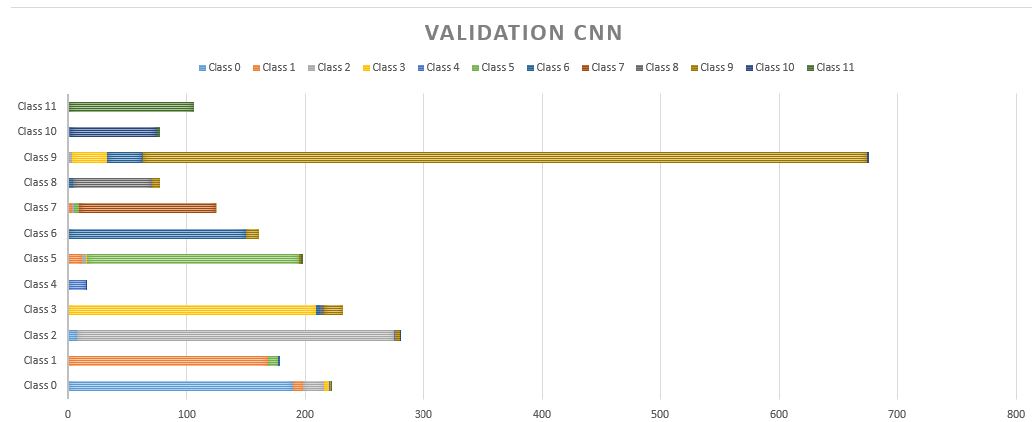
Figure 11. Cross-validation results with 20% for the NN.